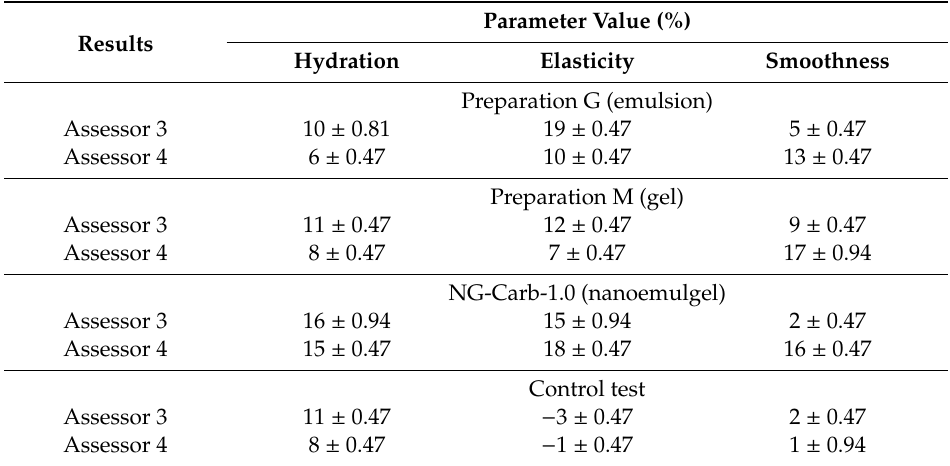
Table 9. Results of the examined preparations concerning their e ff ect on the skin after sunburn.